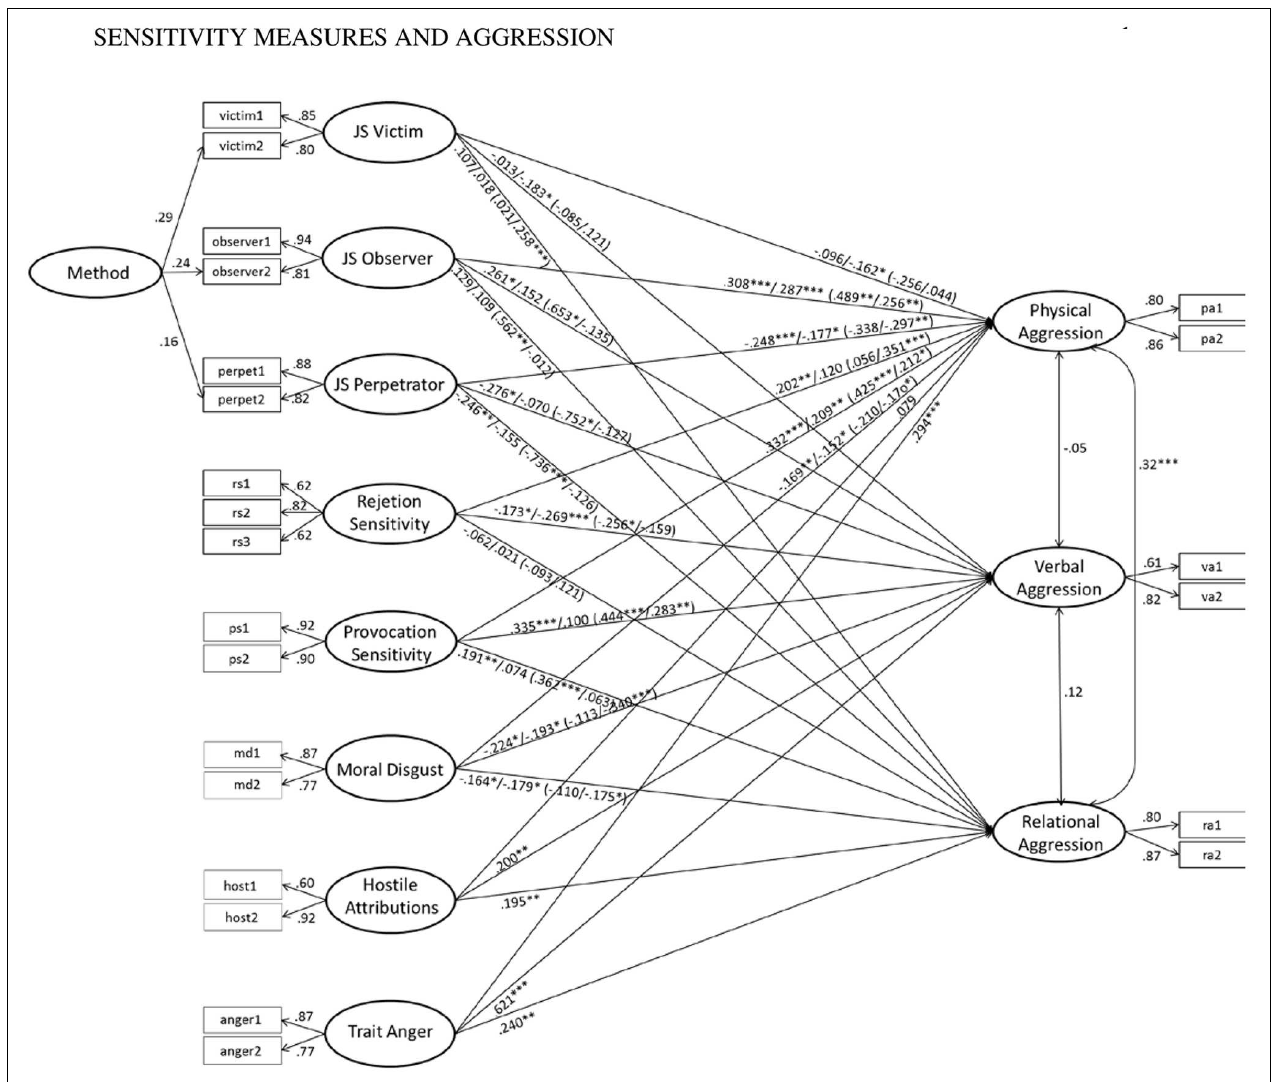
FIGURE 2 | Prediction of forms of aggression (total sample: controlled for gender and age; grouping model: controlled for age; correlations between predictors allowed and estimated). Figures in front of slashes: path weights for the model only including the sensitivity measures, figures after slashes: path weights for the model also including hostile attributions and trait anger. Figures in brackets: path weights for men and women respectively. Total sample (only including sensitivity measures): χ 2 = 230.816, df = 132, p < 0.001, RMSEA = 0.046, CFI = 0.962, SRMR = 0.039, N = 349; Total sample (also including hostile attribution bias and trait anger): χ 2 = 303.183, df = 195, p < 0.001, RMSEA = 0.040, CFI = 0.966, SRMR = 0.038, N = 349; Grouping by gender (only including sensitivity measures): χ 2 = 422.780, df = 266, p < 0.001, RMSEA = 0.058, CFI = 0.940, SRMR = 0.057, N =